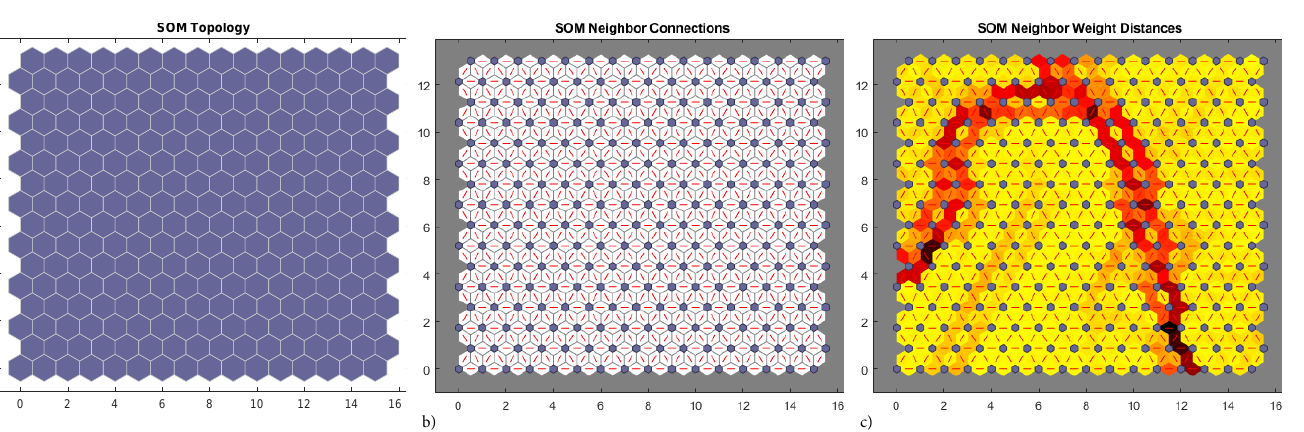
16 topology ( a ), connections ×